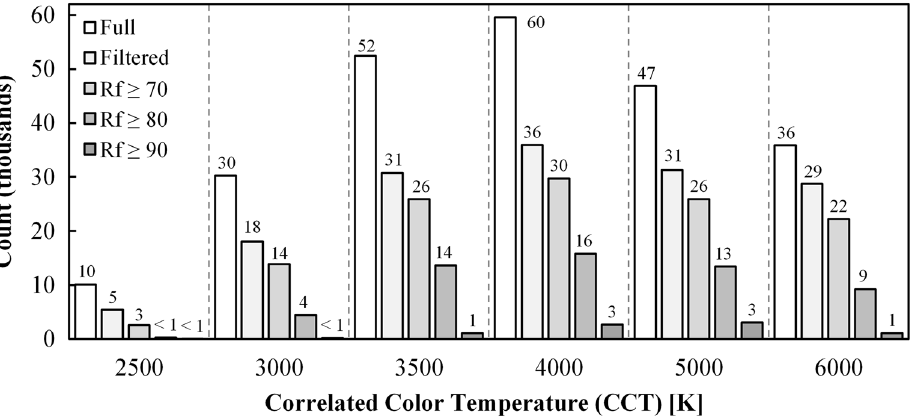
Figure 5. The number of composite SPDs retained at each of the nominal CCTs. The “Full” dataset includes SPDs with D uv ± 0.01; the “Filtered” dataset includes SPDs with the D uv tolerance of the ANSI Basic quadrangles. The other three series are color fidelity filters on the “Filtered” dataset. The nominal CCT with the most retained SPDs was 4000 K, with decreasing frequency at higher and lower